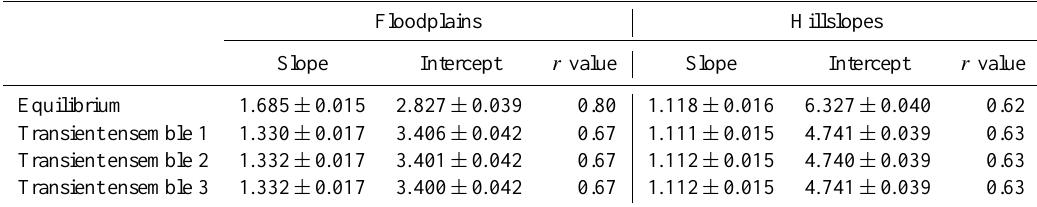
Table 3. Summary of regression results of the scaling of sediment storage after the equilibrium and transient simulations. Here we consider all grid cells in the Rhine catchment area. The r value is the Pearson correlation coefficient, and the slope and intercept are the scaling parameters.